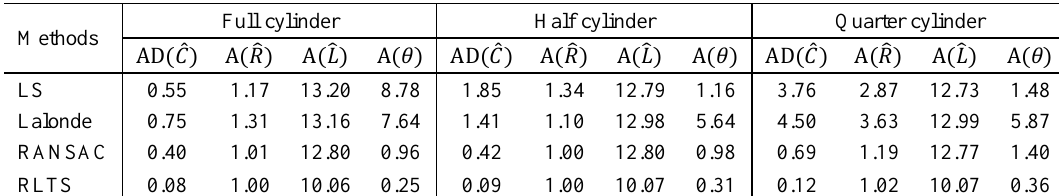
Table 1. Evaluation of estimated parameters for full, half and quarter cylinders